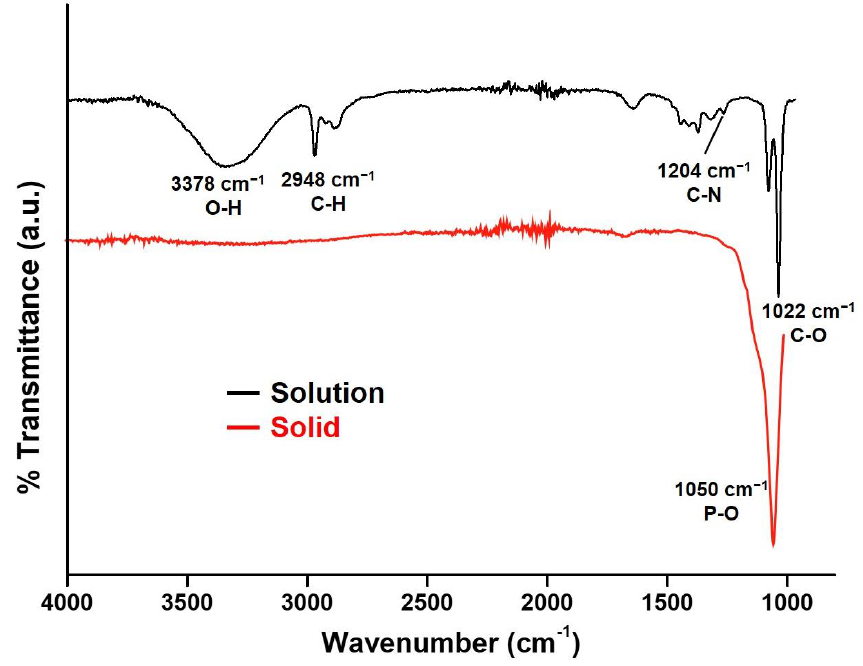
Figure 2. FTIR spectra of the calcium phosphate nanocluster (CaP NC) solution and